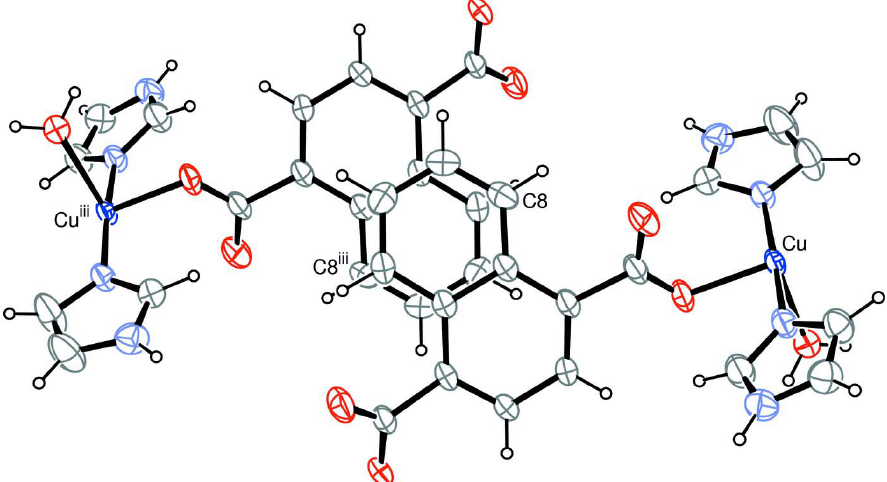
Figure 2 A digram showing the ovelapped arrangement of adjacent naphthaline ligands [symmetry code: (iii) 1 - x , 1 - y , 2 - z